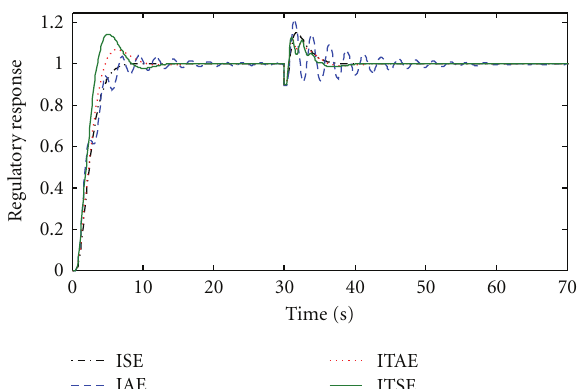
Figure 12: Servo response for Example 2 with I-PD